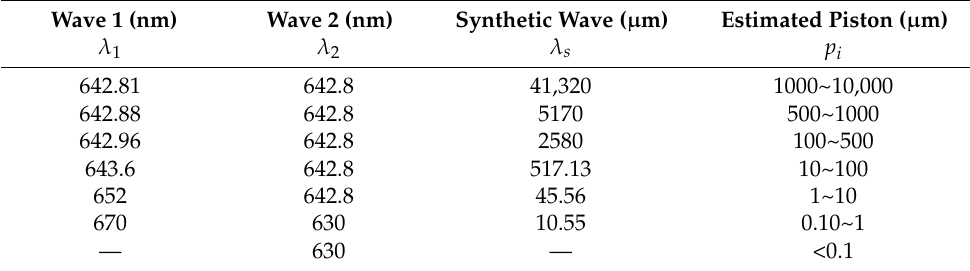
Figure 3. Effect of synthetic wavelength to measure the error. The x-axis denotes the length of the synthetic wave, the y-axis denotes the RMS of the residual piston error for the 20 simulated segments, the blue line sets the SNR to 20 dB with a piston error | ∆ p i | ≤ 0.01mm for each segment, and the red line sets the SNR to 40 dB. Table 2. Multistage synthetic wavelength strategy.